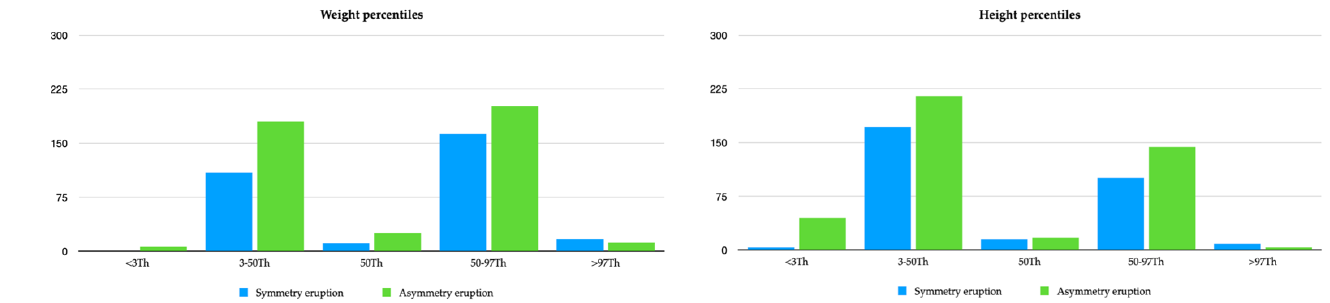
Figure 2. Bar graph of symmetric eruption as a function of percentile. Applying the multivariate logistic regression model, it was determined that for every meter increased in height, the probability of symmetrical eruption increased by a factor of 866.75. Additionally, the probability of symmetry was multiplied by a factor of 0.4 for patients with an undesirable